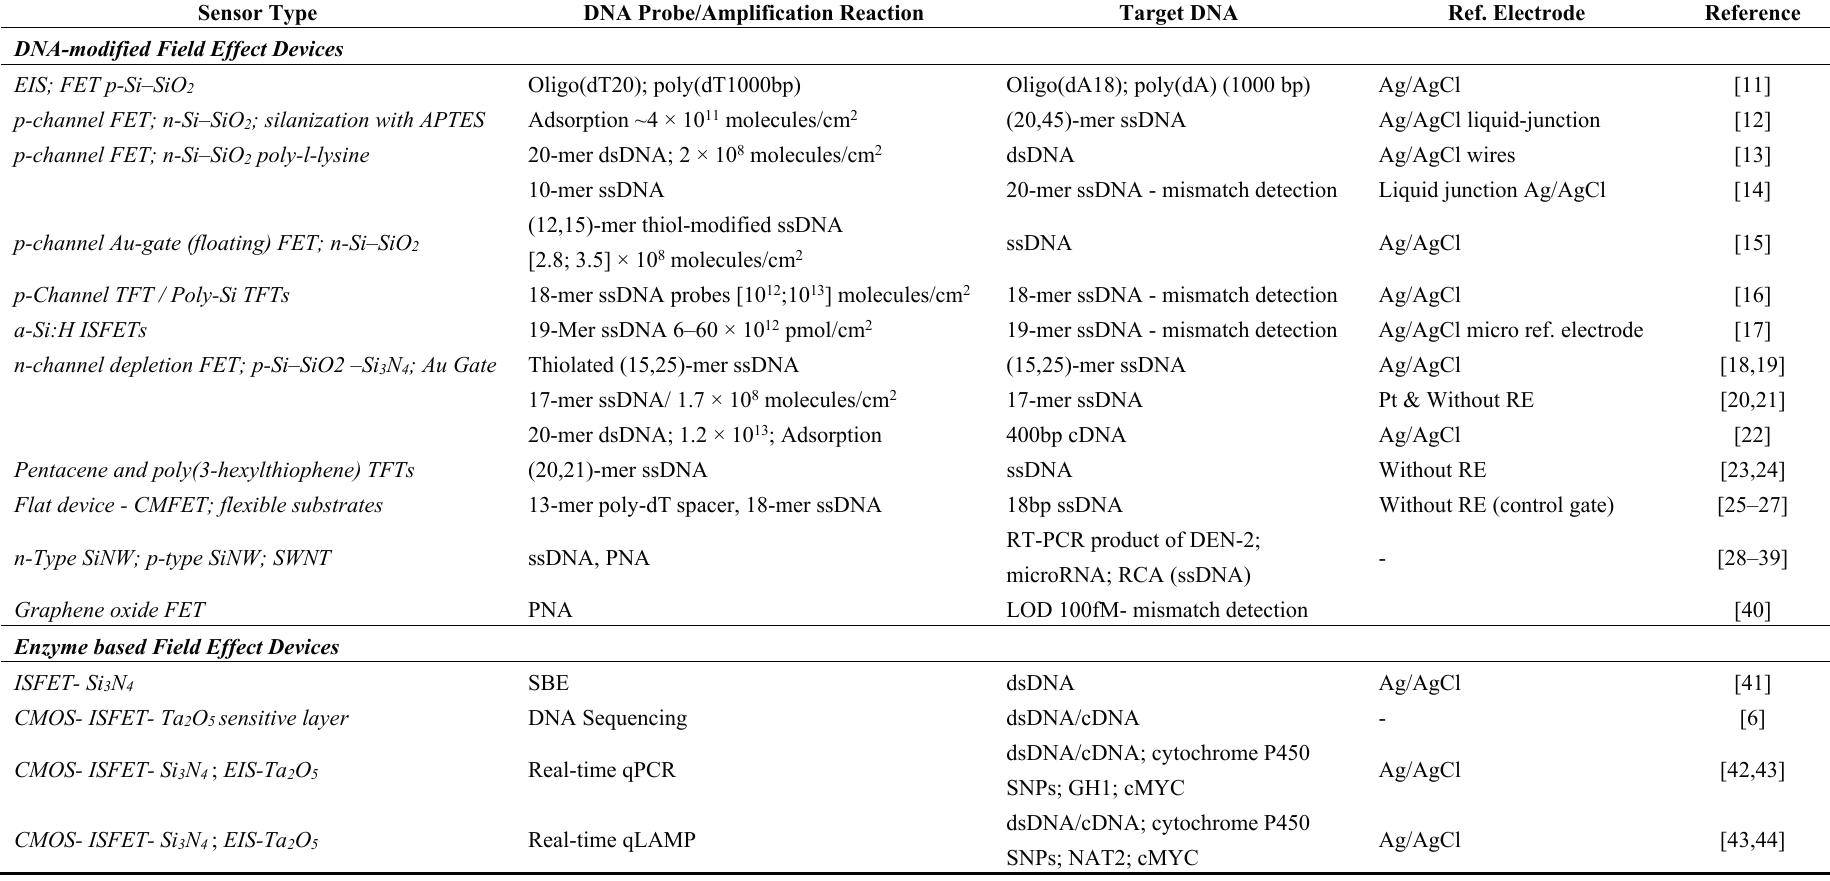
Table 1. Summary of field-effect-based DNA sensors discussed in